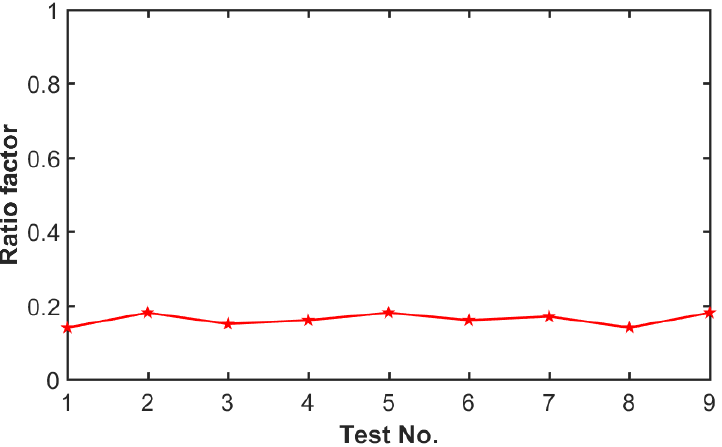
Figure 13. Ratio between sieve loss in the monitoring area and total grain loss.